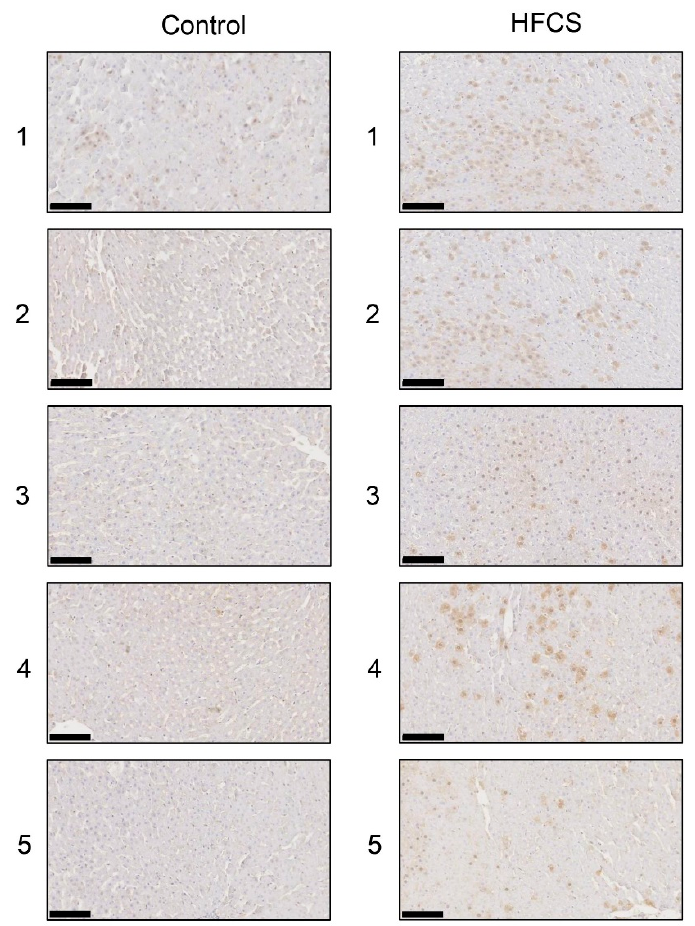
Figure 6. Immunostaining of intracellular TAGE in the liver. The numbers 1–5 indicate each rat in the control group ( n = 5) or HFCS group ( n = 5). Control; control group, HFCS; HFCS group. TAGE-positive areas stained brown in cells. The scale bar represents 100 µ m.